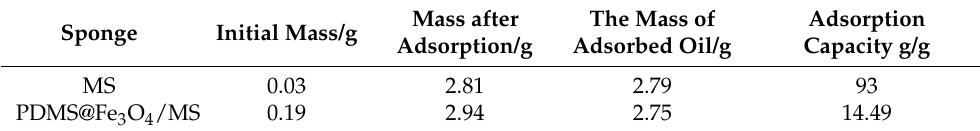
Figure 8. Separation efficiency of PDMS@Fe 3 O 4 /MS for different oil ‐ water mixtures.